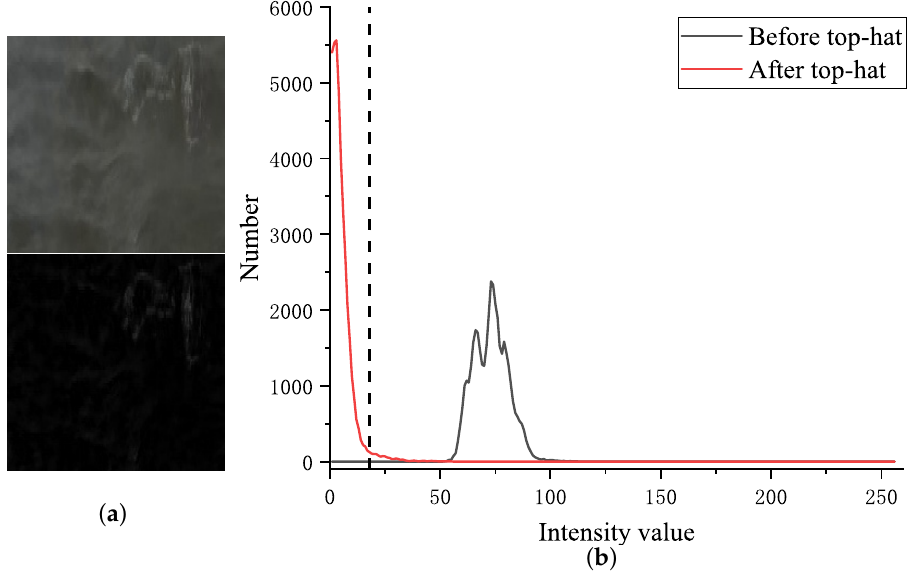
Figure 4. ( a ) The original grayscale image and the image after top-hat transformation; ( b ) histogram of image before and after the top-hat transform. The dashed line represents the threshold found by the knee point determination